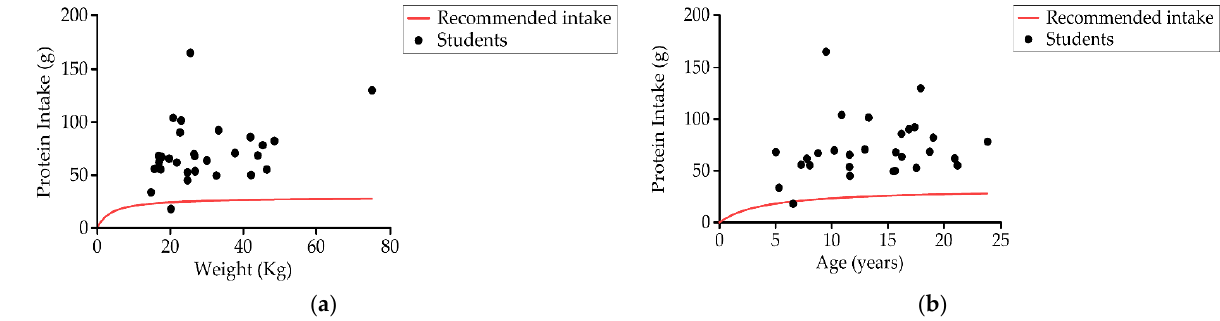
( b ) Figure 6. Relationship between students’ ( a ) energy intake (kcal/day) and weight, and ( b ) energy intake (kcal/day) and age compared to recommendations of energy intake ( n = 29). b)